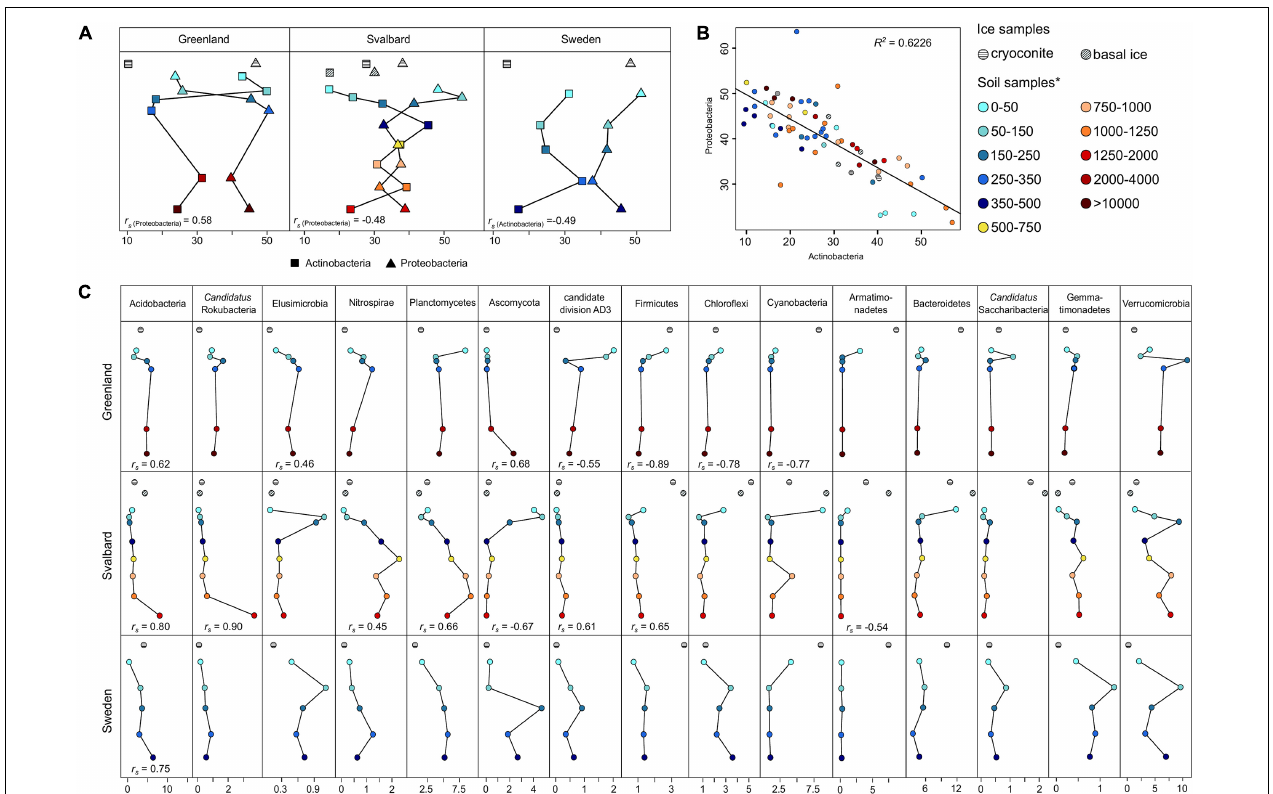
FIGURE 5 | Taxonomy classification at the phylum level. (A) Actinobacteria and Proteobacteria trends in the dataset. (B) Linear model relation between Actinobacteria and Proteobacteria relative abundances ( p -value = 3 × 10 - 15 ). (C) Remaining phylum trends in the datasets. Spearman’s rank correlation coefficient ( r s ) was calculated between the sample distance and the relative abundance data for each phylum. r s is reported below the appropriate line plot only when significant ( p -value < 0.05). *Soil samples are categorized in relation to their distance from the ice edge (m).